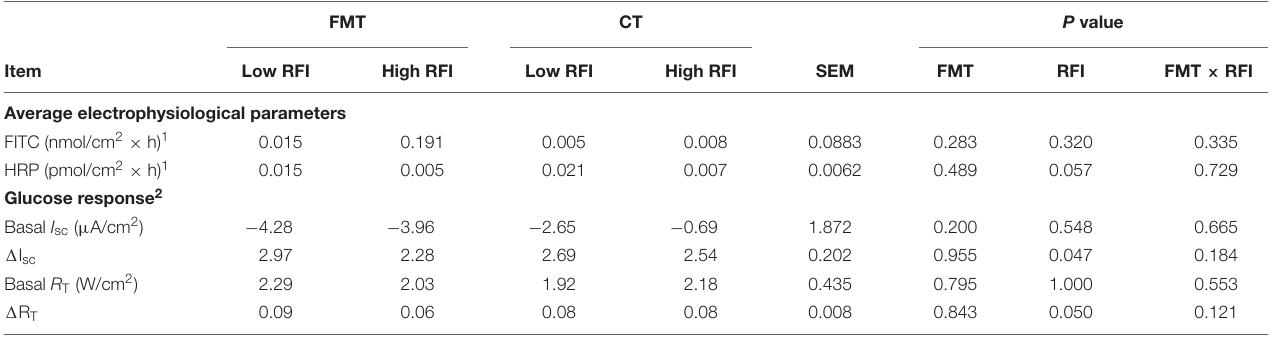
TABLE 3 | Differences in mucosal permeability and response to luminal glucose addition in distal jejunum of low and high residual feed intake (RFI) broiler chickens receiving either a fecal microbiota transplant (FMT), or a control transplant (CT). FMT CT P